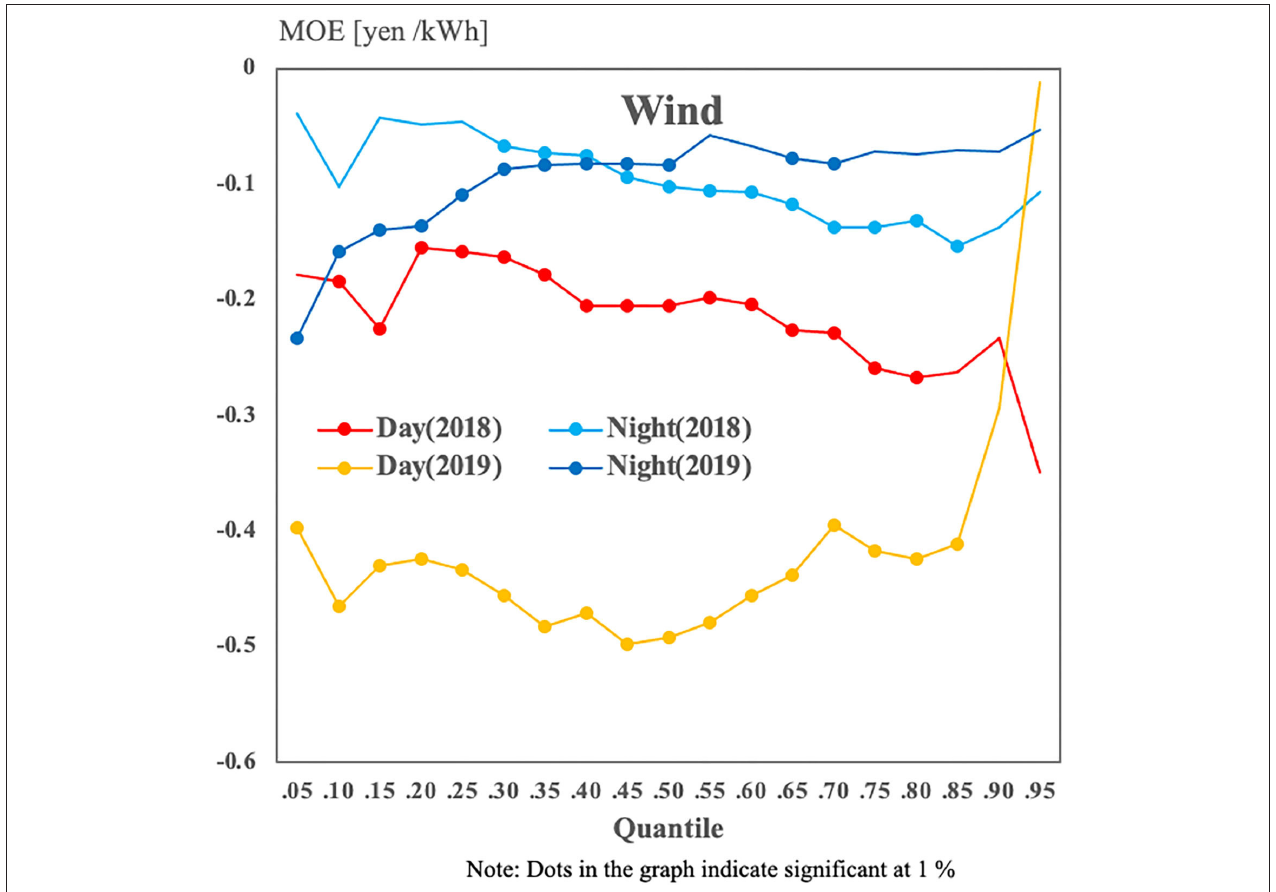
FIGURE 5 | MOE differences between daytime and night-time hours by price range. (Source: created by authors). The dots in the graph indicate significance at the 1% level.